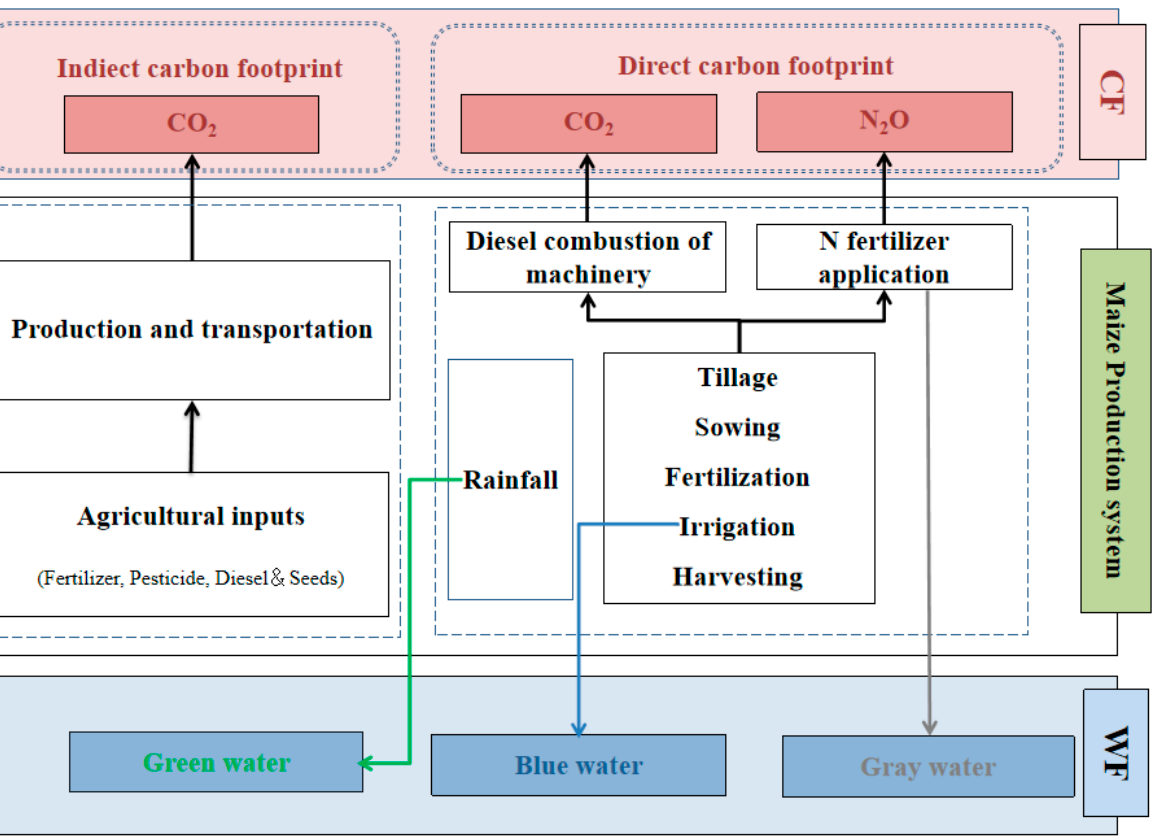
Figure 2. System boundaries of the carbon footprint (CF) and water footprint (WF) of maize production.